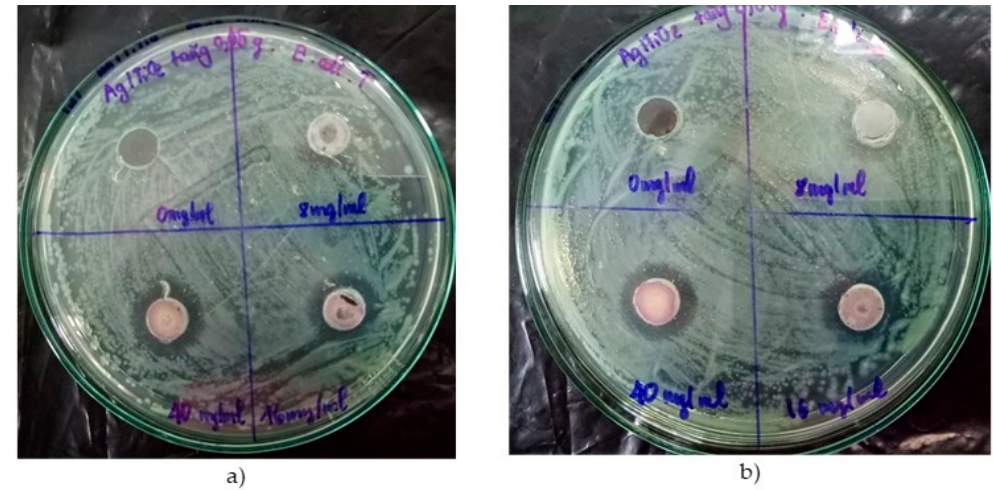
Figure 8. Photographs of antibacterial test against Escherichia coli bacteria (agar-well diffusion method) for Ag-loaded TiO 2 nanoparticles: ( a ) without light irradiation; ( b ) under light irradiation). Concentration of 8, 16, and 40 mg/mL.